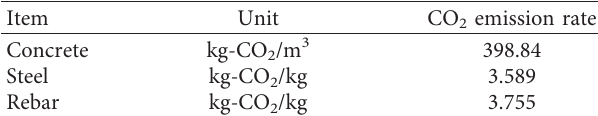
Table 10: The quantity of CO